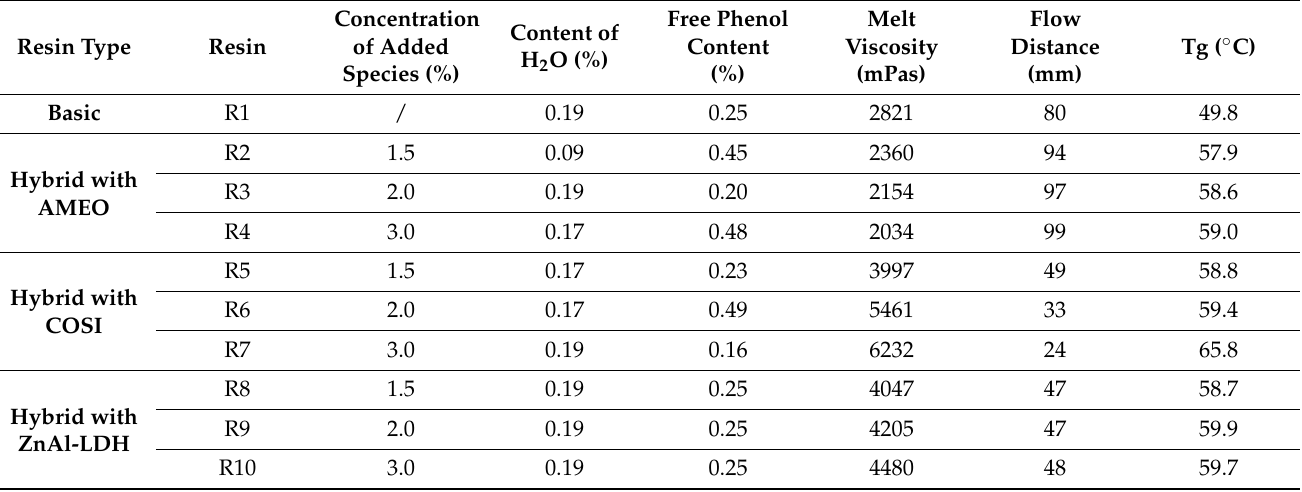
Table 1. Water and free phenol content, melt viscosities, flow distances, and glass-transition tempera- tures of all synthesized